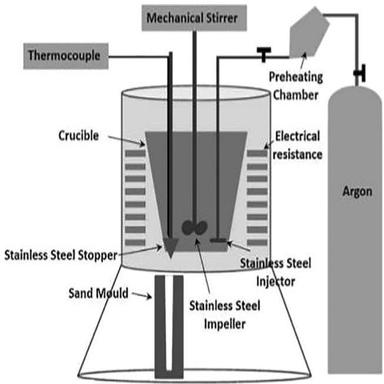
Stir casting Equipment Setup.